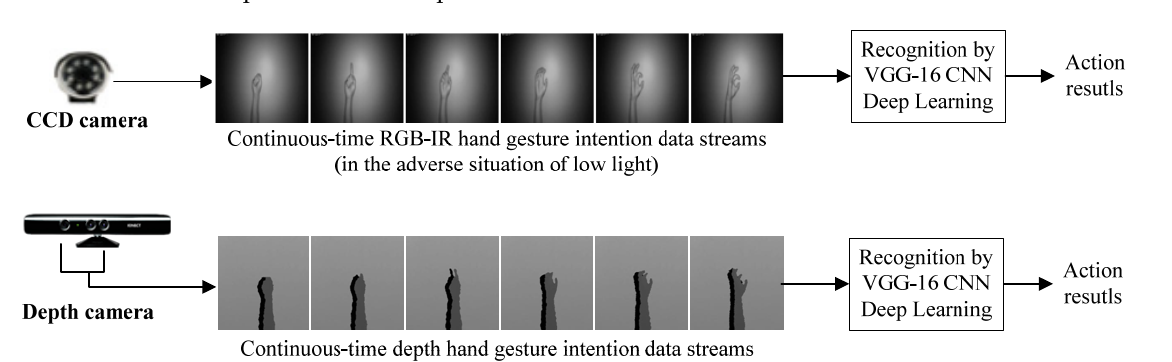
Figure 2. The typical VGG-16 CNN deep learning recognition framework with only one modality Figure 1. Frameworks of VGG-16 CNN deep learning [24] for the continuous-time hand gesture channel to process the same type of sensor data (the CCD RGB-IR modality or the depth cam- data stream (10 gesture classification nodes set in the final layer). era-derived depth-grayscale modality in an environment of low illumination).